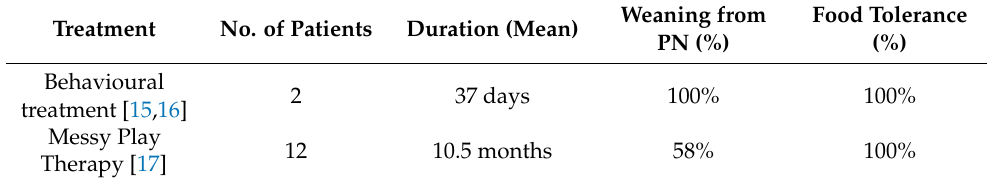
Table 4. Treatment characteristics and